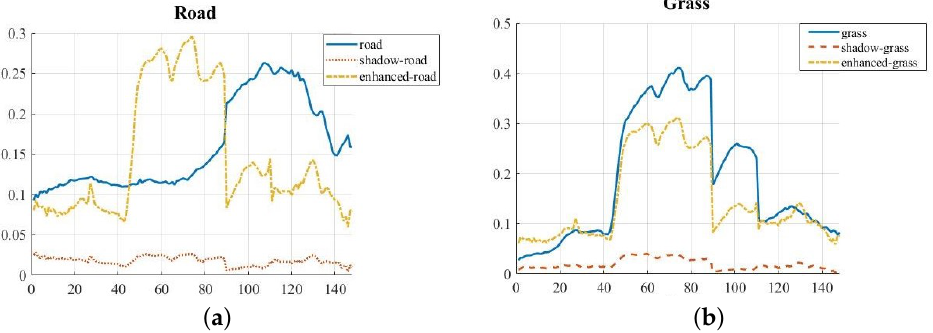
Figure 14. Comparison of spectral curves. Solid, dashed, and dotted lines represent the spectral curves of road and grass not in the shadow area, in the shadow areas, and after enhancement, respectively. ( a ) Spectral curves of road. ( b ) Spectral curves of